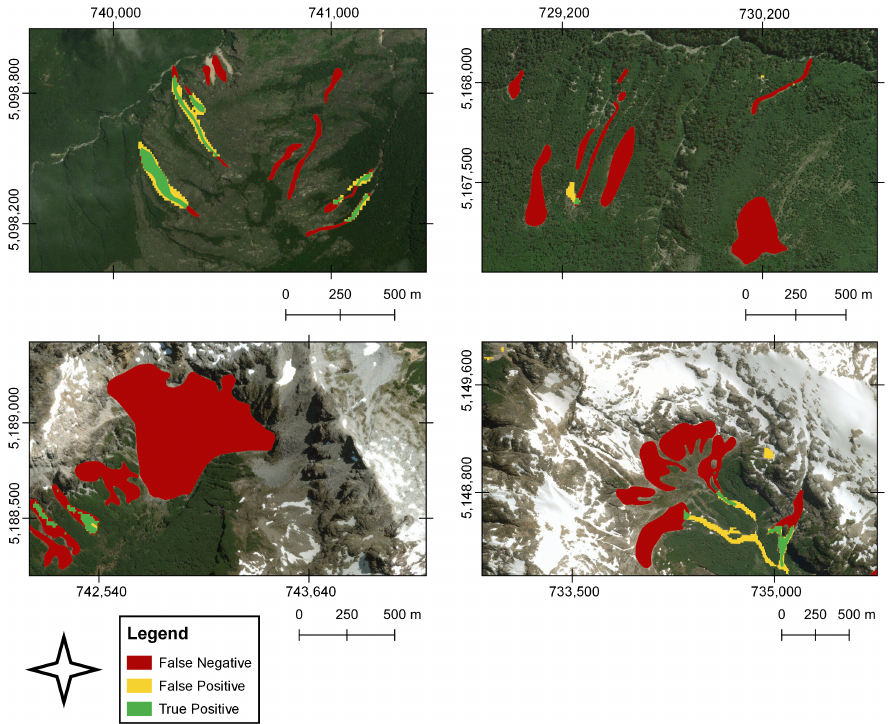
Figure 5. Landslide mapping using the trained model in a test area in Patagonian Andes. The main errors of the automatic mapping are